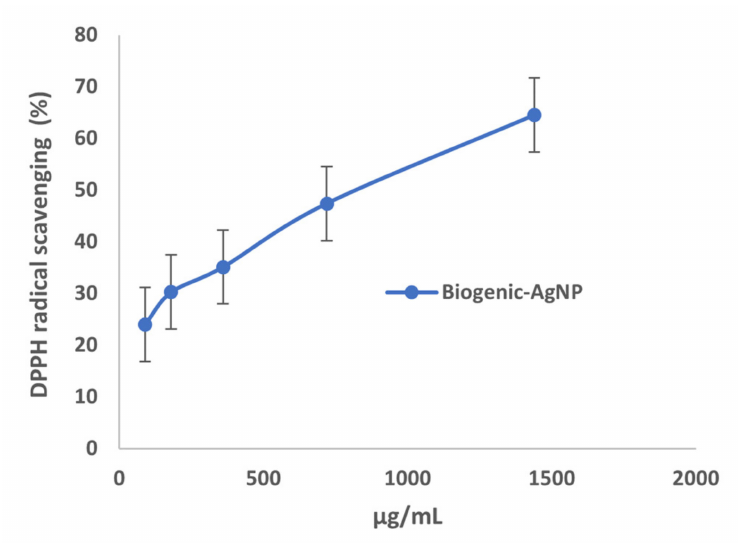
Figure 3. DPPH scavenging reduction of